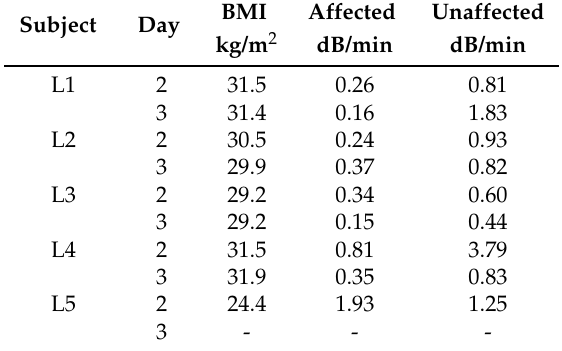
Table 4. Deviation in time of propagating galvanic signal on lymphoedema affected participants, Day 2, without fluid restriction, and 3, after fluid restriction and ingestion of 350 mL of